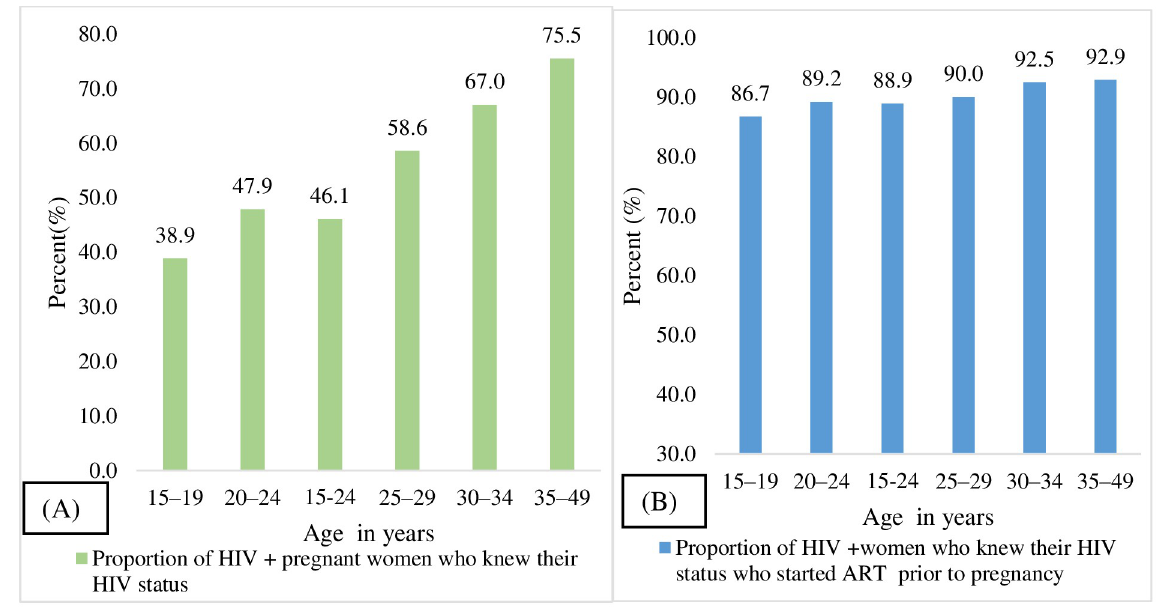
Fig 3. Knowledge of HIV-positive status (A) and ART initiation (B) prior to pregnancy by age group, in the 2017 antenatal HIV sentinel survey, SA.